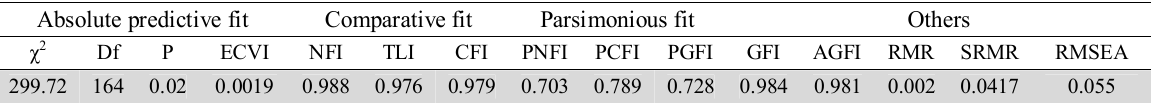
Fit indices for the default model Absolute predictive fit Comparative